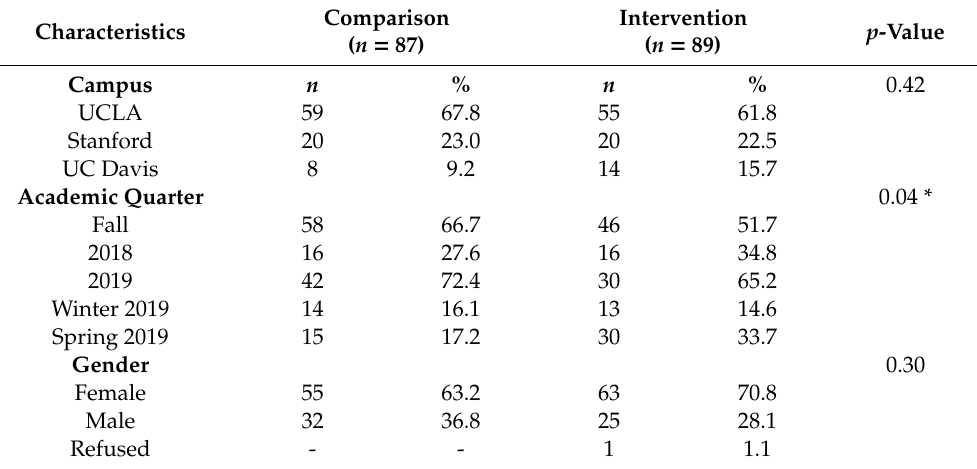
Table 2. Study participant characteristics by study group ( n =